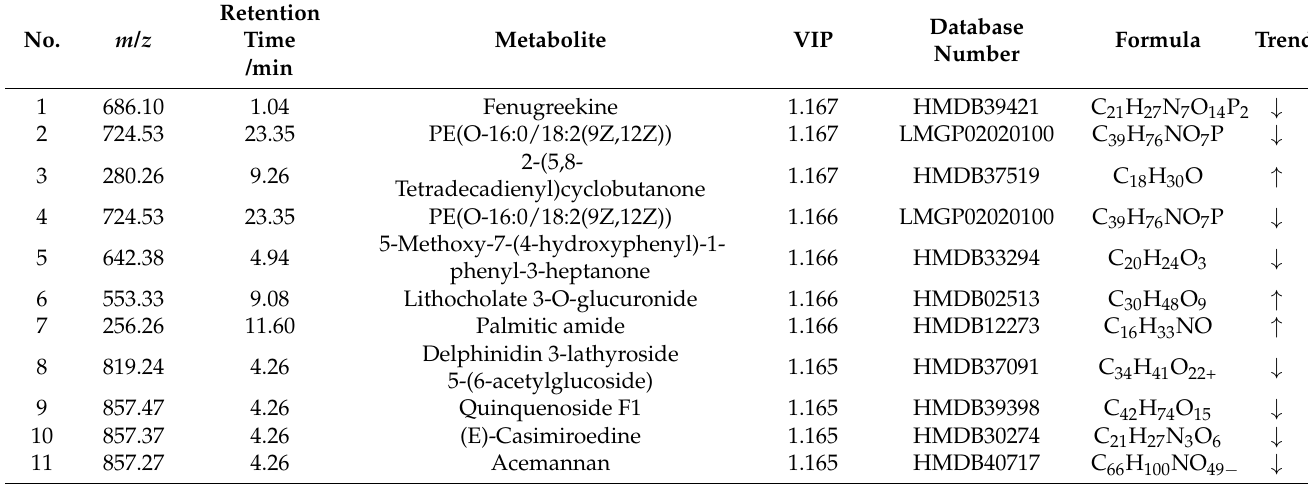
Table 3. Potential differential metabolites between the ox-LDL and NaB